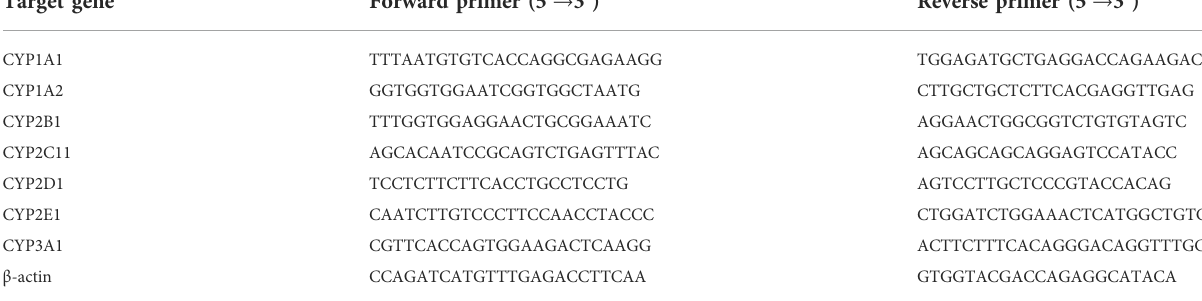
TABLE 1 Primers to amplify the target